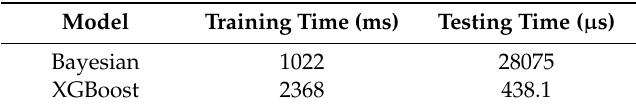
Table 6. Comparison of di ff erent algorithms training and testing